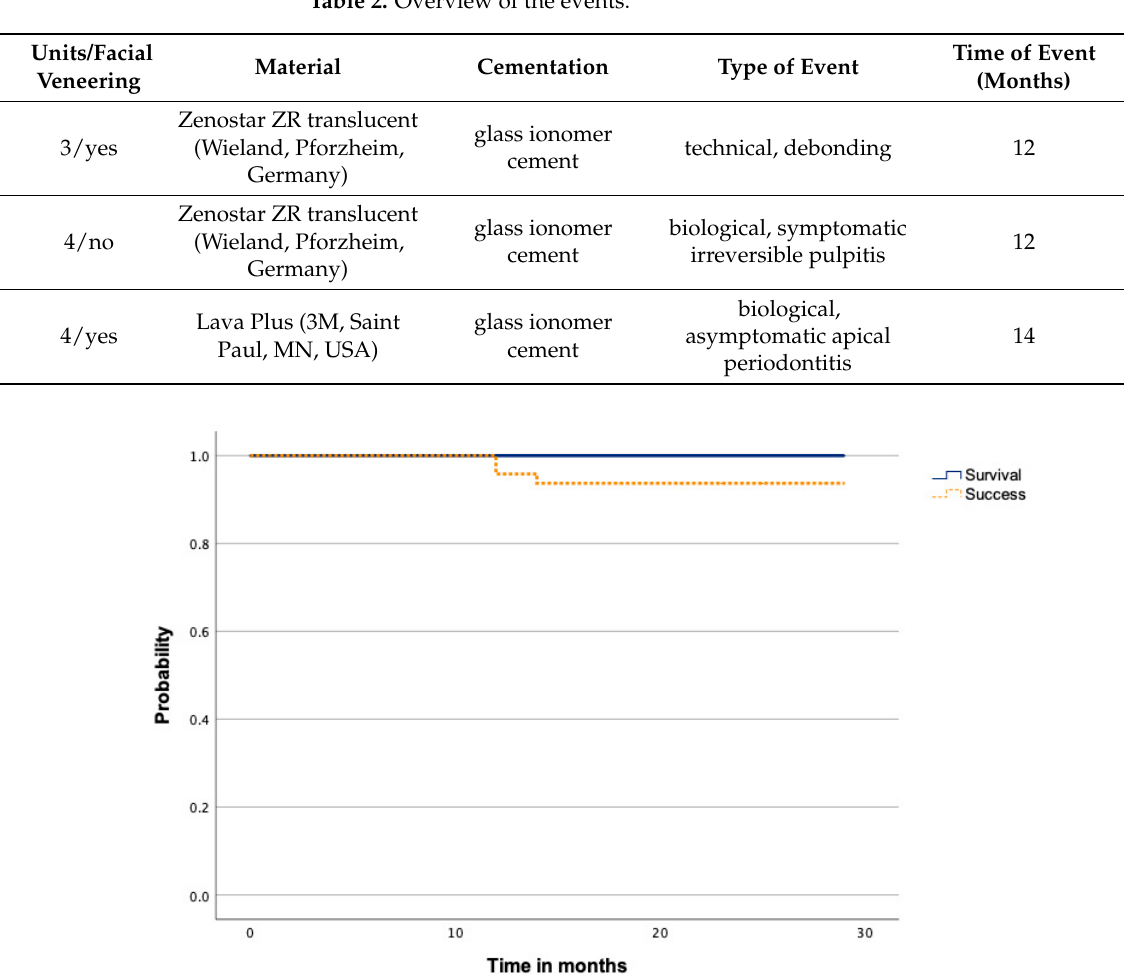
Figure 1. Kaplan–Meier curves for the survival and success of multi-unit fixed partial dentures with monolithic occlusal surfaces fabricated from zirconia (insertion n = 50; 2-year follow-up n =